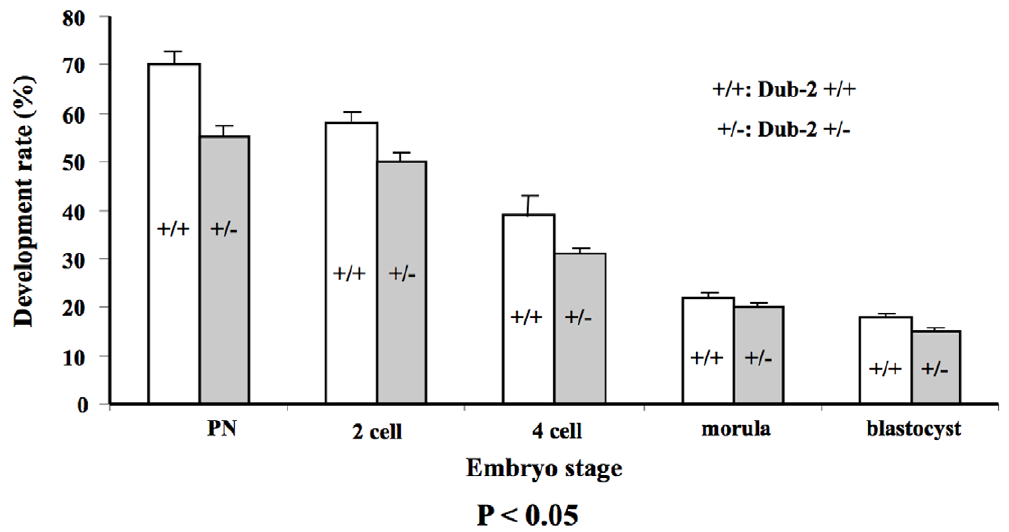
Figure 6. Effect of Dub-2 + / 2 heterozygous gamete (oocyte and sperm) on invitro fertilization and embryo development. In vitro fertilized zygotes were cultured for 96 hrs (post hCG) in the basic culture media and scored at subsequent preimplantation stages (post hCG 48 hrs, 65 hrs, 72 hrs, and 96 hrs). Experiments were performed three time and the data are expressed as percentage 6 SEM. doi:10.1371/journal.pone.0044223.g006 PLOS ONE |